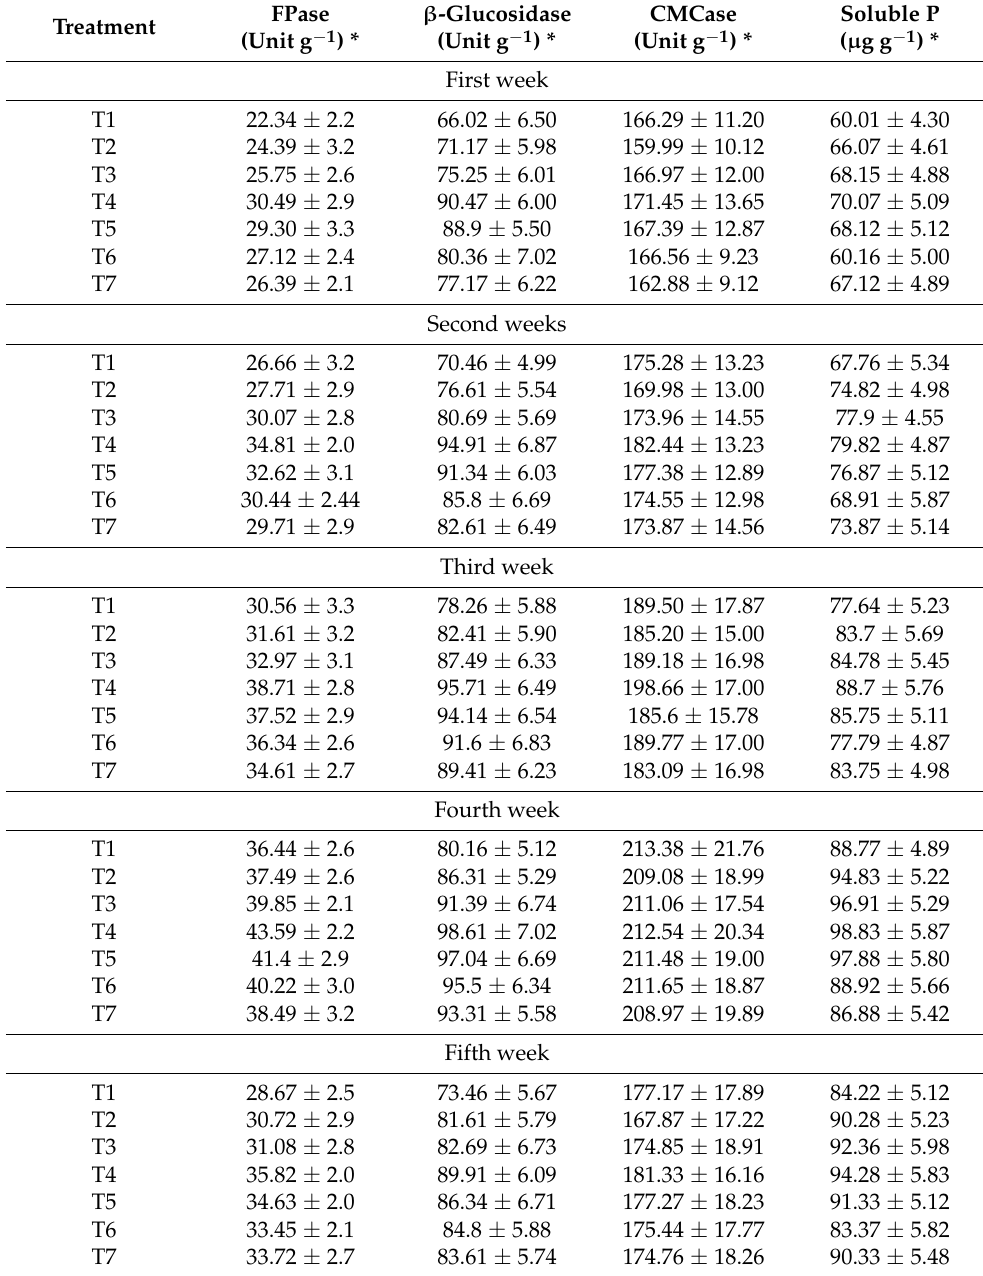
Table 3. Time-course profiles of cellulase production and P solubilization by A. japonicus under different ratios of sugarcane bagasse and faba bean straw